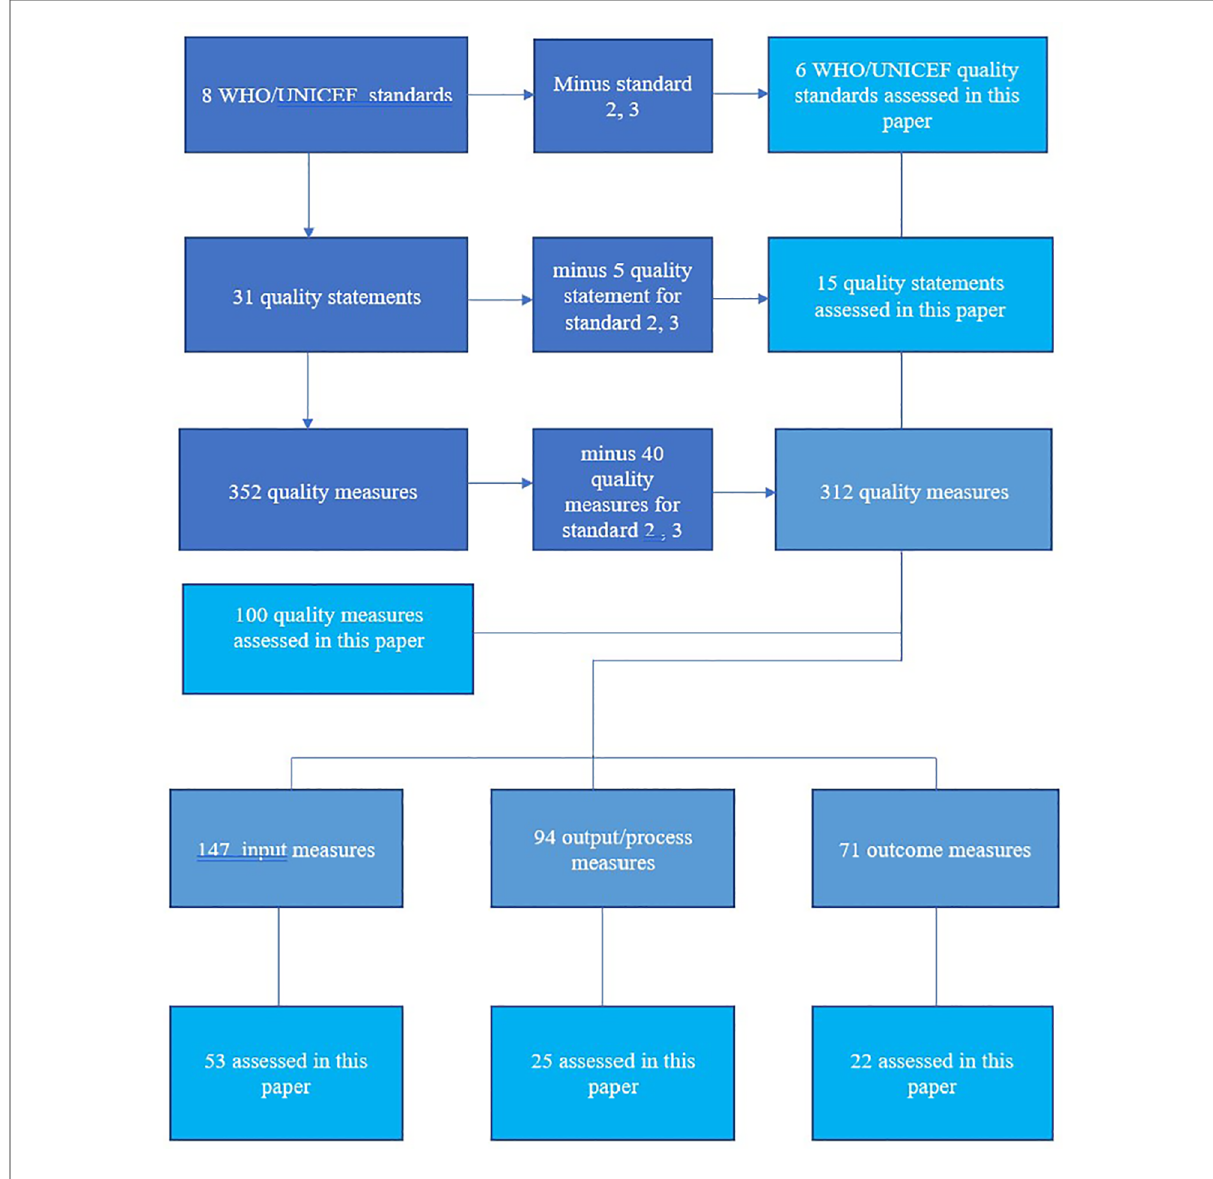
FIGURE 1 Standards, statements, and measures under review in this